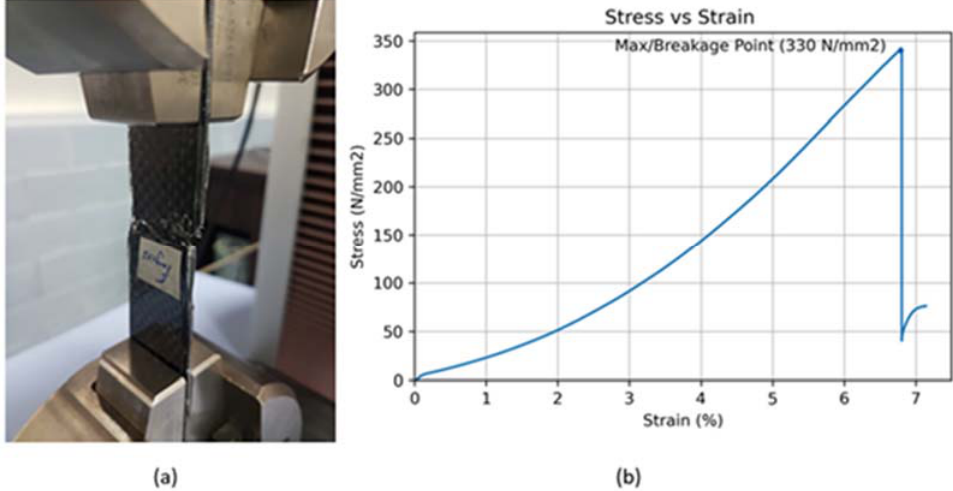
Figure 2. ( a ) Tensile Test for carbon-fiber composites in UTM ( b ) Mechanical behavior of carbon-fiber composites in